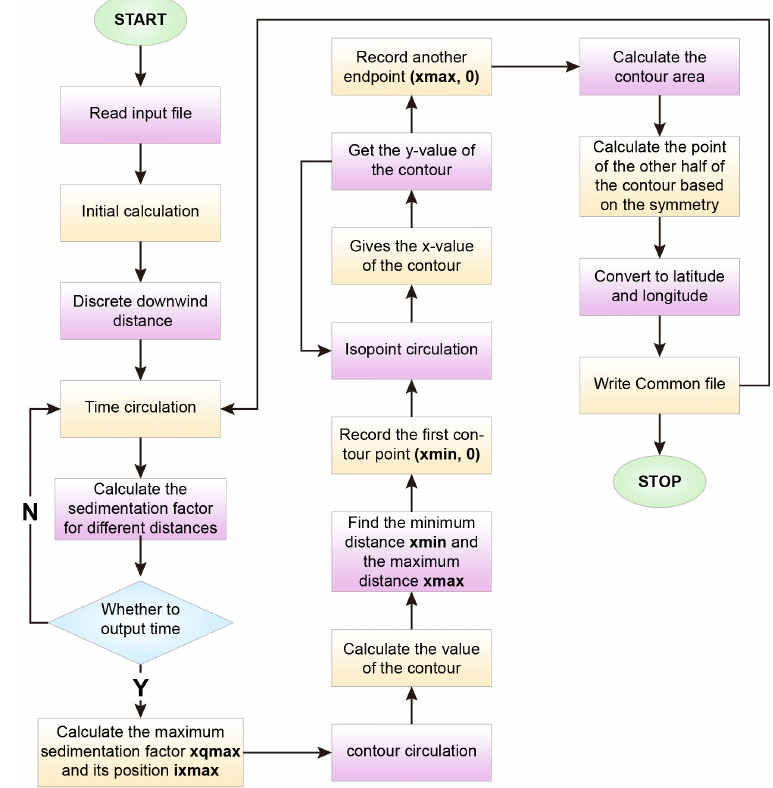
Figure 2. Block diagram of the data flow of the software analysis.